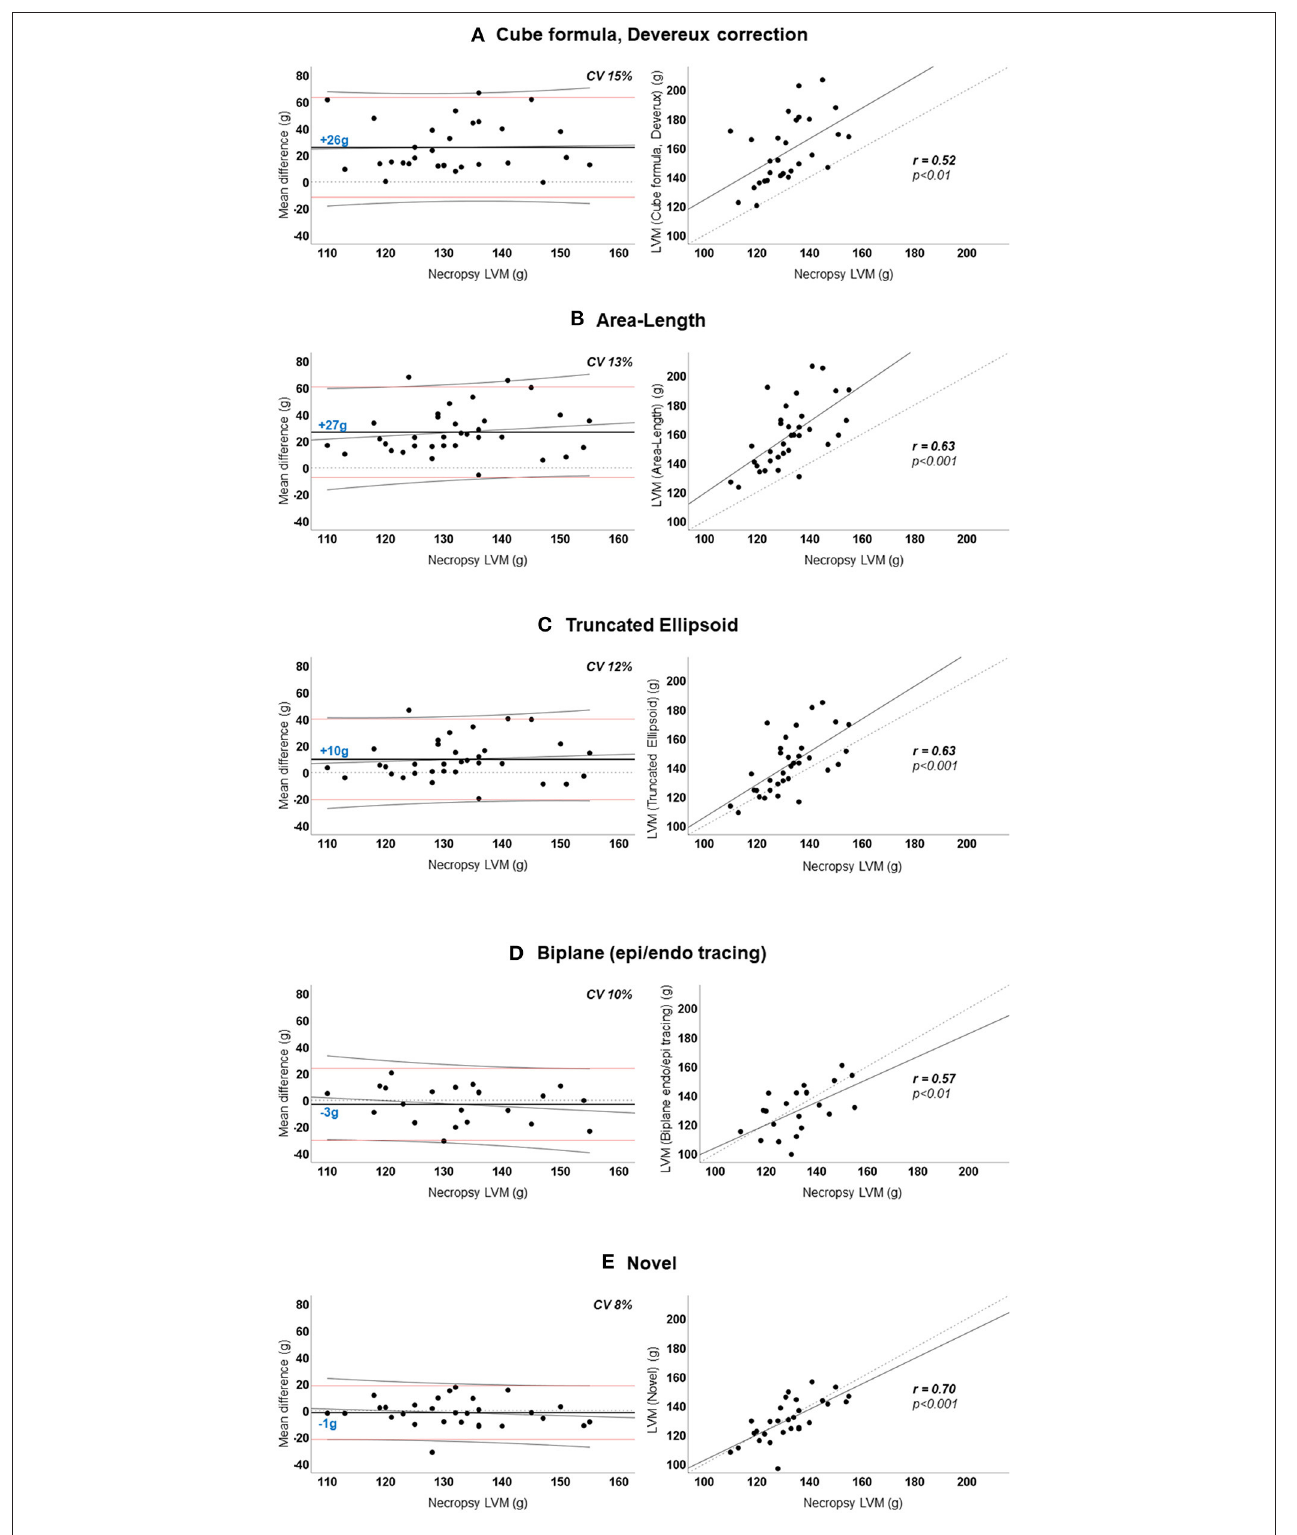
FIGURE 3 | (A–E) Agreement between echocardiographic left ventricular mass and necropsy left ventricular mass. Left panel: Agreement between mean difference (echocardiographic-LVM – necropsy-LVM) and necropsy-LVM. Horizontal dotted black line indicates 0 (no difference). Horizontal solid black line and blue number is the mean difference; positive value indicates overestimation by echocardiography. Horizontal red lines are the 95% limits of agreement. Diagonal thin black line is the regression line with 95% confidence interval visualizing the proportional bias. Right panel: Linear regression curves of echocardiographic-LVM and necropsy-LVM with Pearson’s correlation coefficient (r). Diagonal dotted line is the reference line. LVM , left ventricular mass; CV , coefficient of variation.